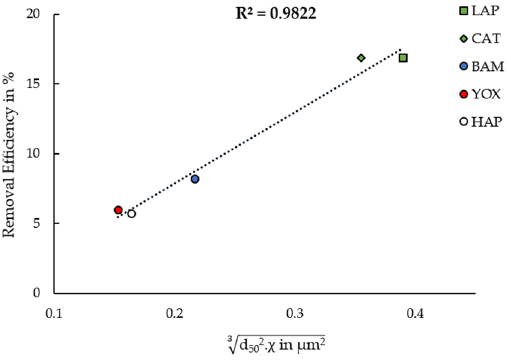
Figure 4. Correlation between the phosphors’ .